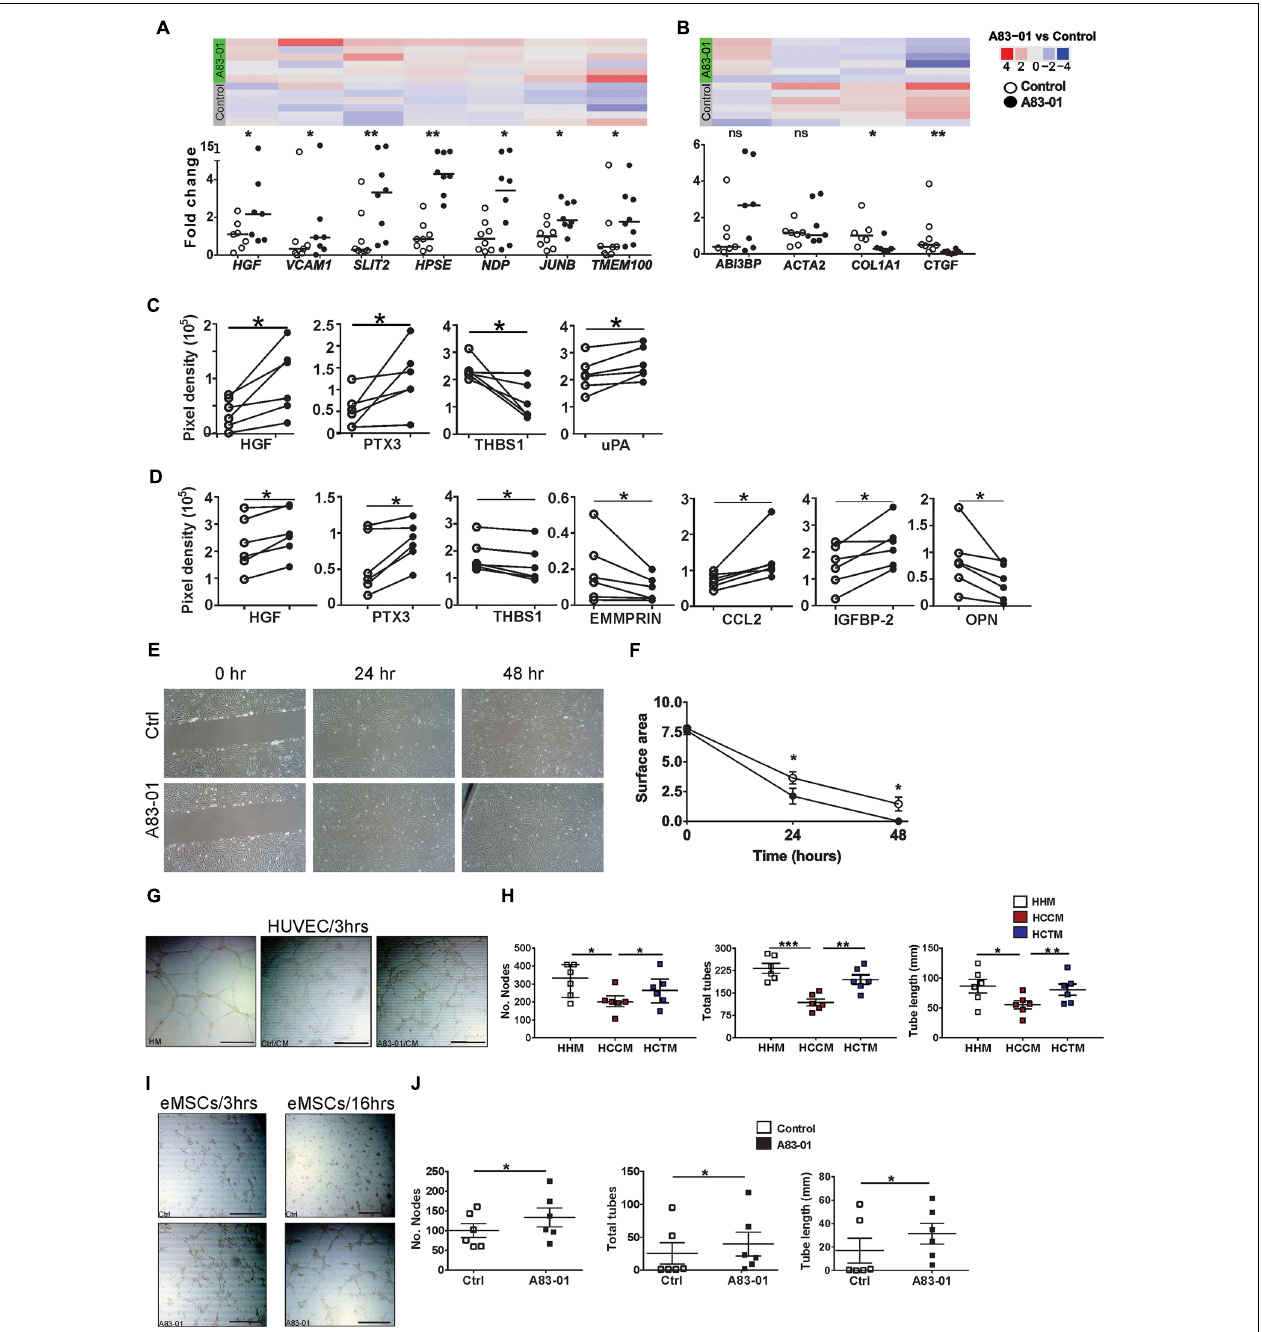
FIGURE 2 | A83-01 treated-eMSCs secrete angiogenic factors and enhance angiogenesis. (A,B) Validation of angiogenesis-related genes in A83-01-treated versus control eMSCs using Fluidigm qPCR. Data points from each individual donor ( n = 6–8) are presented; black circles, A83-01-treated; white circles, vehicle controls, bars are medians. The corresponding heat map of RNA-seq is from six independent donor eMSCs (original set). Angiogenesis-related proteins in (C) cell-lysates and (D) CM in A83-01-treated and control eMSCs. ( n = 6, graphs are symbols and line to demonstrate corresponding pairs of A83-01 treated (black circles) and control (white circles) eMSCs. (E) Representative images of A83-01-treated and control eMSCs using in vitro scratch test at 0, 24, and 48 h assessing cell migration and proliferation and (F) graph of wound closure. Data are presented as means ± SEM, ( n = 6). (G) Representative images showing enhanced tube formation by HUVECs incubated with HM, CM from A83-01-treated or control eMSCs (scale bar: 500 µ m) 3 h after cell seeding. (H) Graphs show quantification of number of nodes, tubes and total tube length. Data are medians with interquartile range n = 6. (I) Representative Images of enhanced tube formation following culture of eMSCs with A83-01 and control 3 and 16 h after seeding in Matrigel (scale bar: 500 µ m). (J) Graphs show quantification of number of nodes, tubes and total tube length. Data are median with interquartile range, n = 6. ∗ p < 0.03, ∗∗ P < 0.002, ∗∗∗ P < 0.0002. HHM: HUVECs with HUVEC media (HM), HCCM: HUVECs with control eMSC conditioned media, HACM, HUVECs with A83-01 treated-eMSC CM.